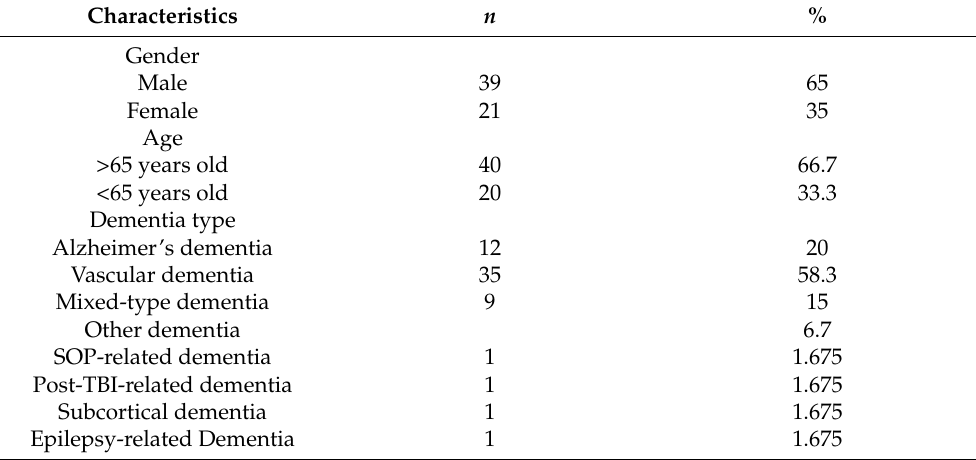
Table 1. Baseline characteristics of research subjects.